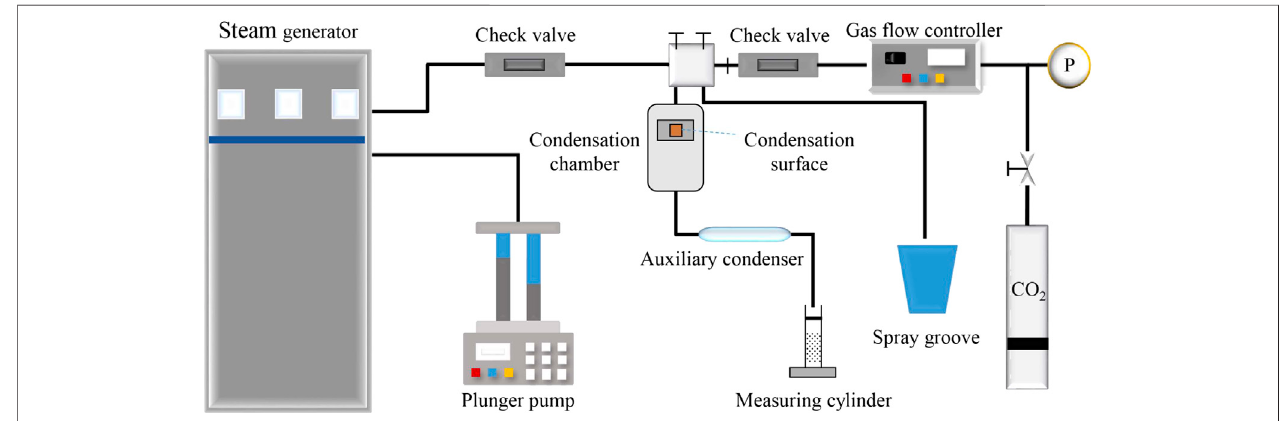
FIGURE 2 | Condensation experiment process.